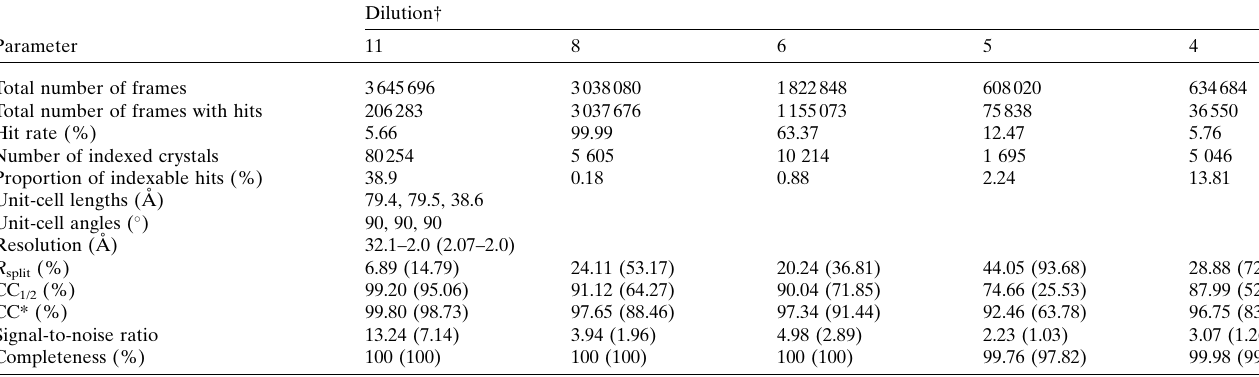
Table 3 SFX data collection and refinement